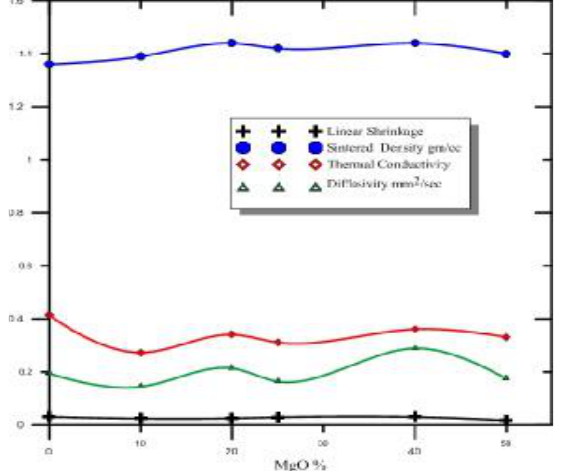
Fig. 8. The linear shrinkage, sintered density, thermal conductivity, and the diffusivity for the Porcelanite prepared refractory as a function of MgO